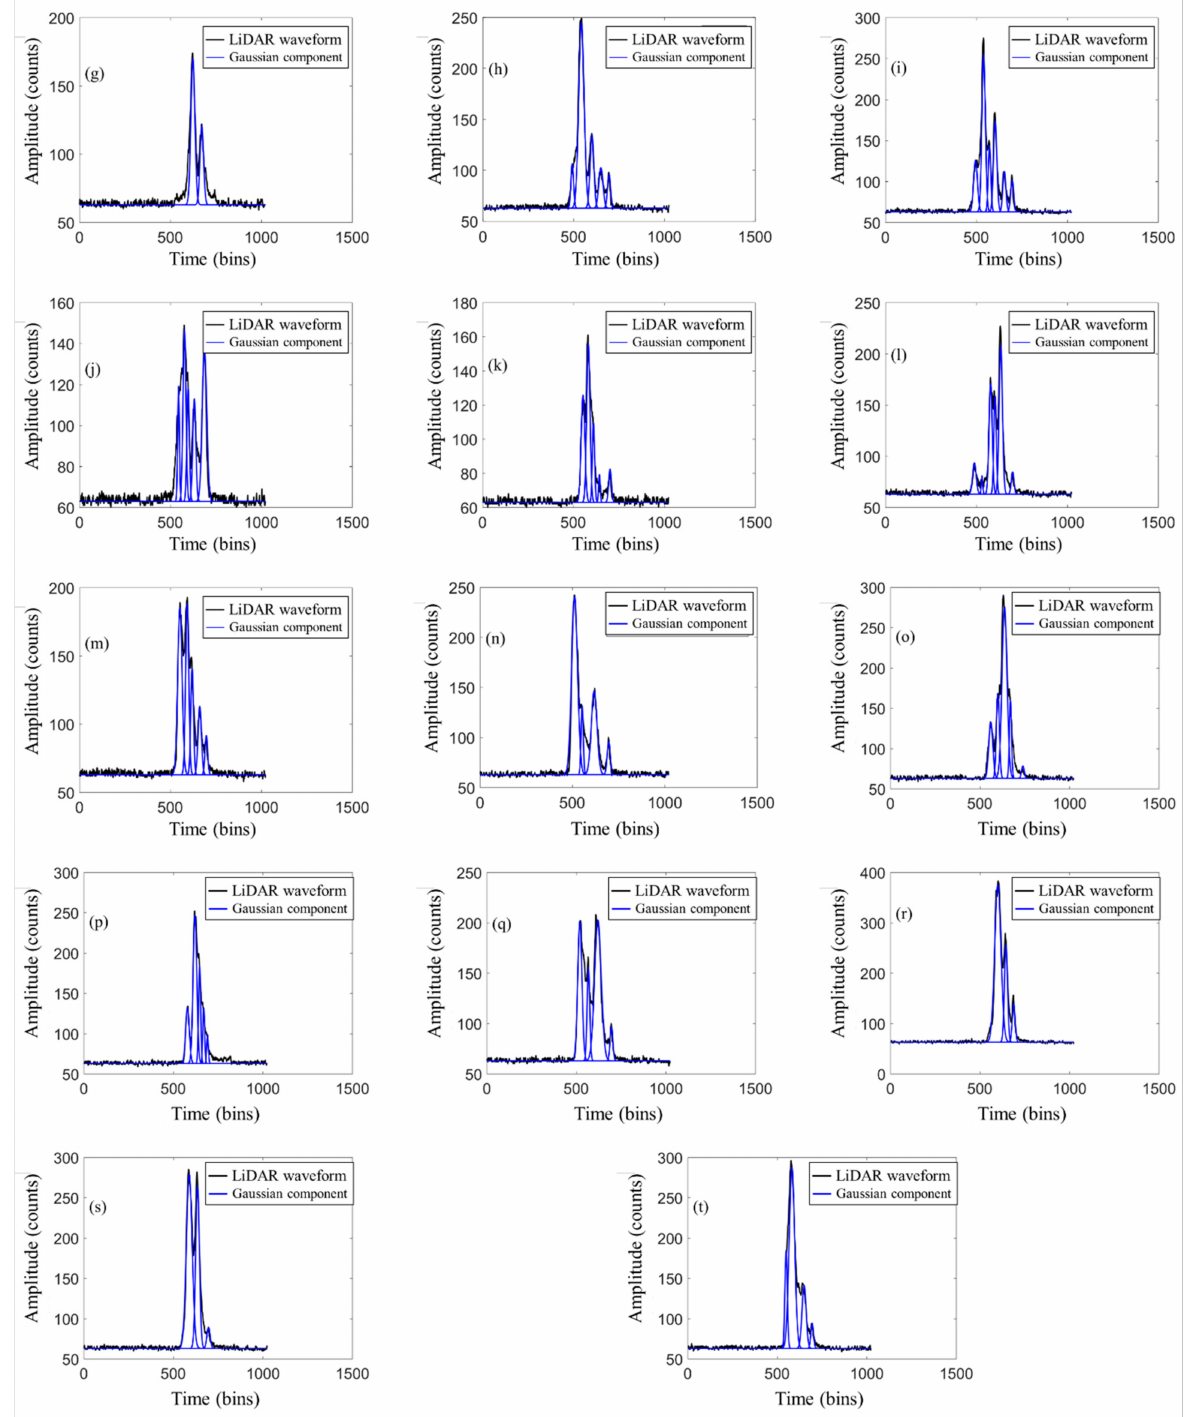
Figure A1. ( a – t ) LiDAR waveform data and LiDAR echo decomposition waveform in the Congo region. The abscissa is the sampling time point of the LiDAR waveform and the ordinate is the amplitude coordinate of the